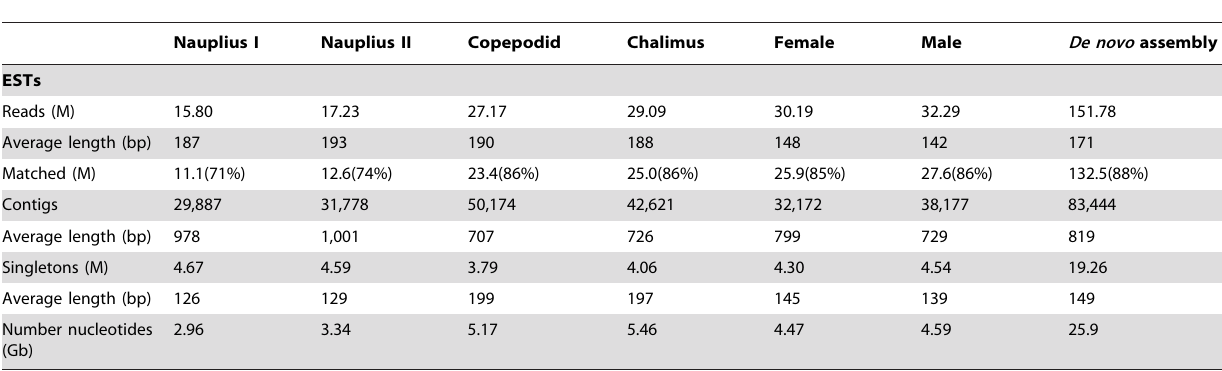
Table 1. Summary of illumina sequencing from salmon lice Caligus rogercresseyi transcriptome.